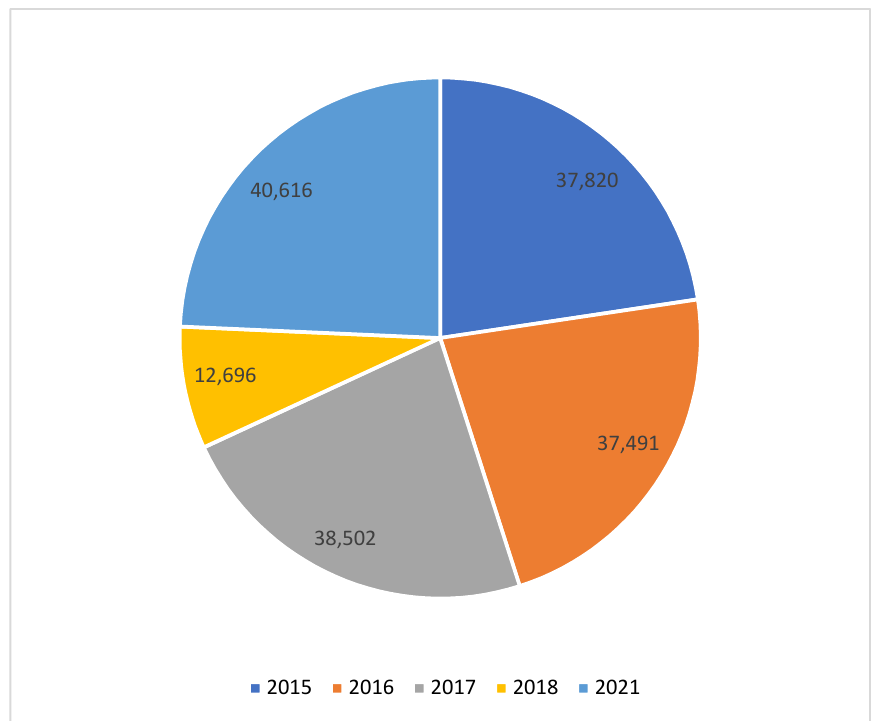
Figure 7. Total number of visitors in given years before and after COVID-19 (March to July).